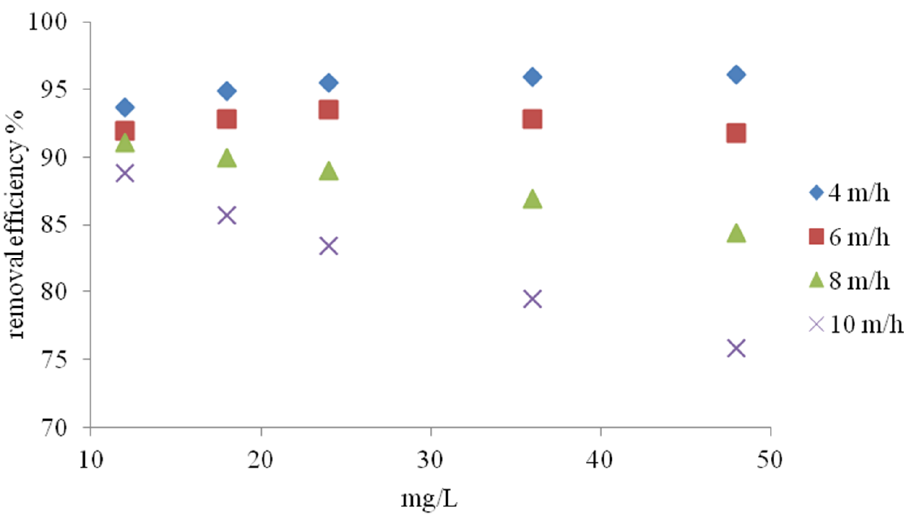
Figure 11. Effect of flow rate on the removal efficiency of different ammonia concentrations from NH 4 Cl solution in tap water.